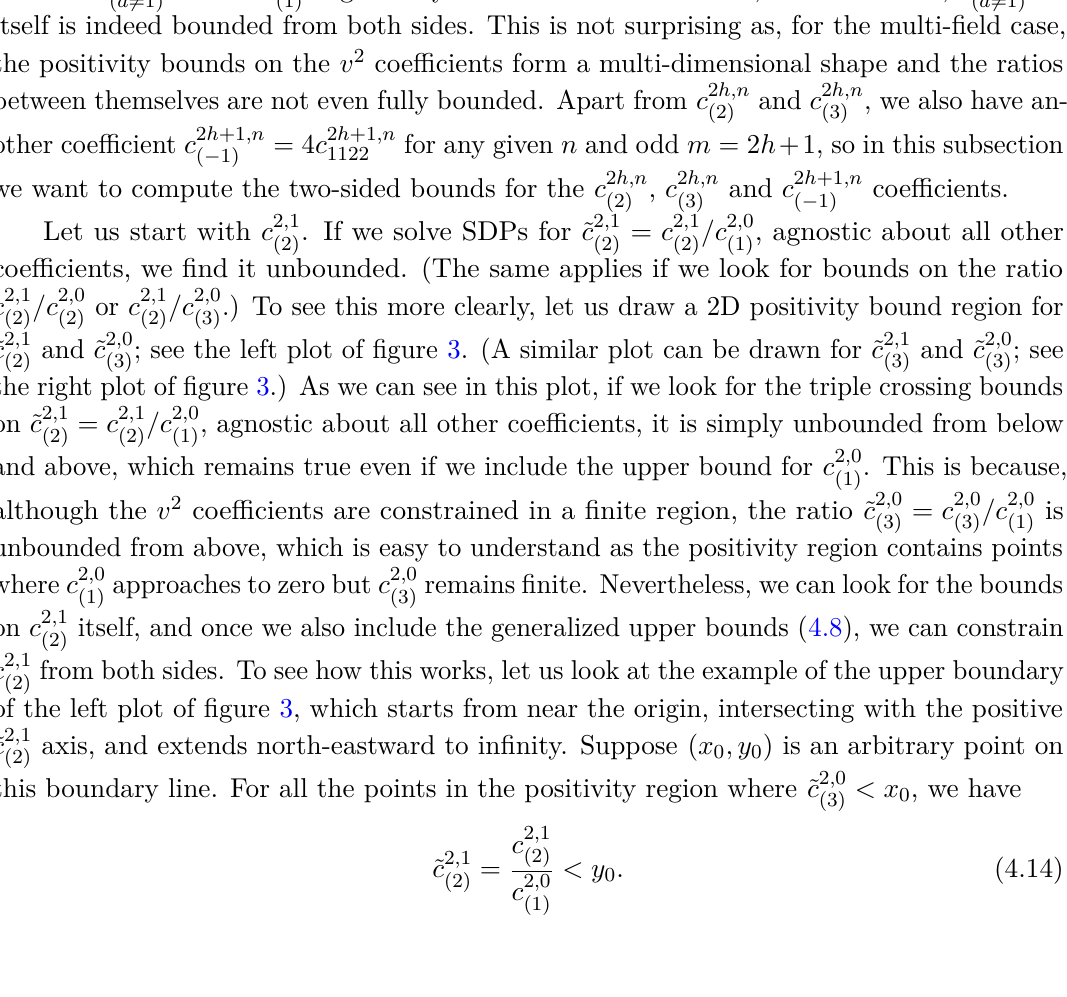
Figure 2 . Positivity bounds on (˜ c 2 , 0 double Z symmetry in the ˜ c m,n 2 is the Wilson coefficient in front of the ( s + t c m,n ijkl tilded coefficients are defined as ˜ c m,n see that the triple crossing positivity bounds form a closed, finite region in the parameter space, numerically of order O (1)